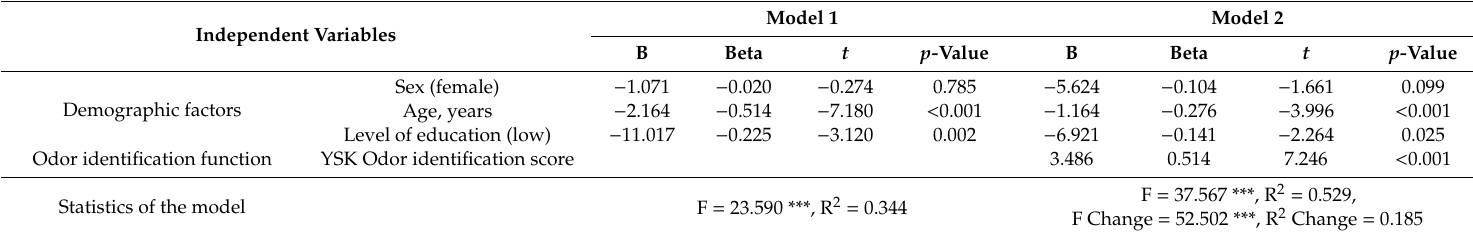
Table 2. Results of linear regression analyses with the CERAD-K score as the dependent variable ( n = 139).